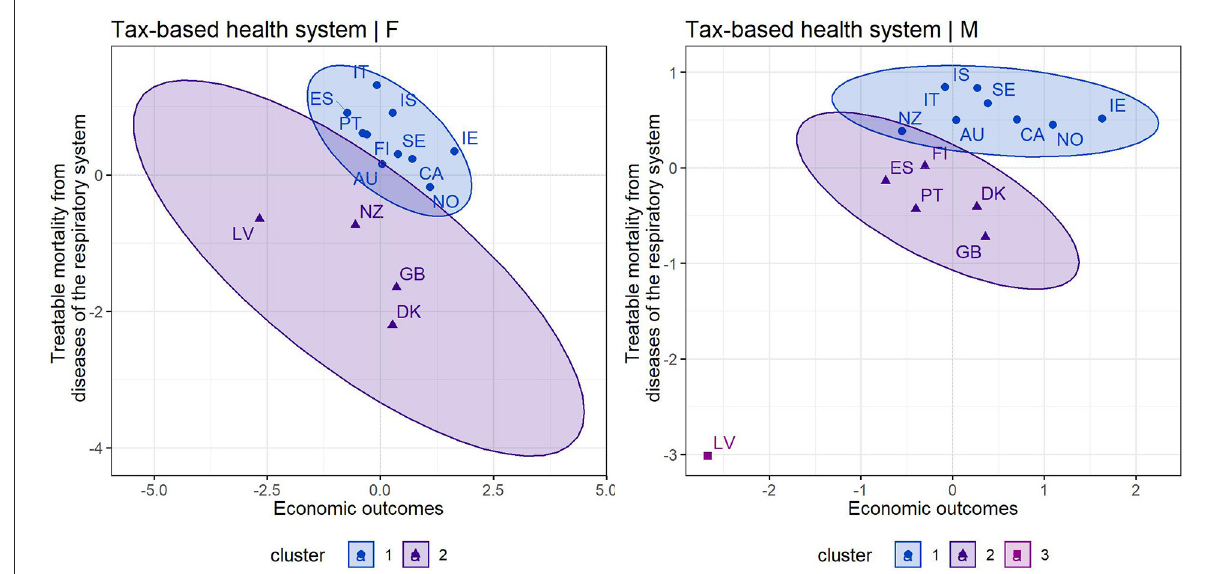
FIGURE1 Cluster maps of countries applying a tax-based health system [left—female population, right—male population) [Source own processing based on available data